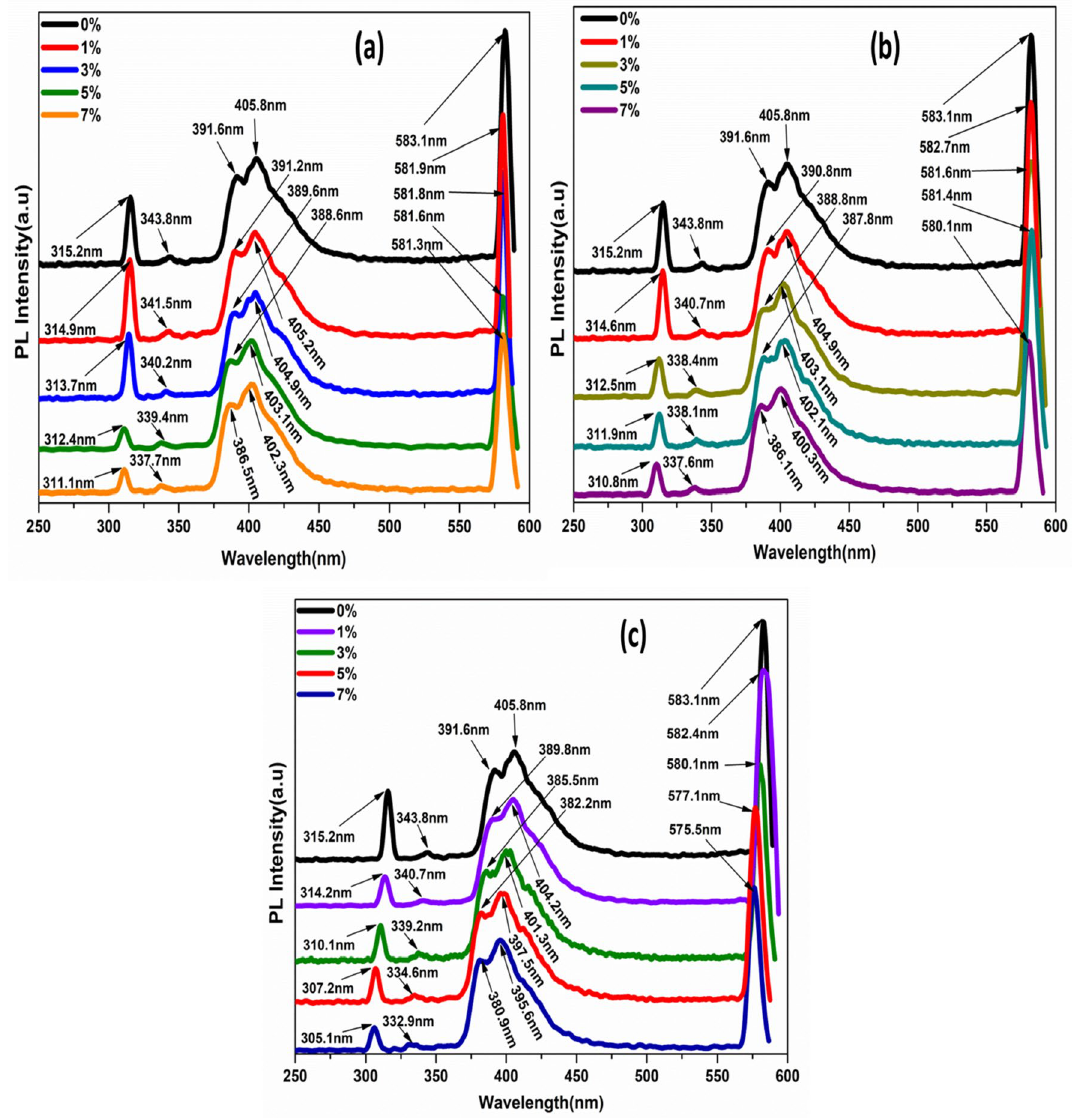
Figure 9. Photoluminescence spectra of Pure MgO metal oxide and transition metal MgO nanoparticles doped with: ( a ) Ni, ( b ) Co and ( c ) Fe with the different The PL spectra of transition metal 1% Ni-doped MgO nanoparticles have five peaks originating around 314.9, 341.5, 391.2, 405.2, and 581.9 nm. The first and second peak corresponds with the ultraviolet region. The other three peaks correlate to violet, violet, and yellow in the visible region, respectively. The intensity of emission peaks varies as the concentration of Ni in the MgO nanoparticles varies, as shown in Fig. 9a. Furthermore, the peak was shifted toward a lower wavelength with increasing Ni ion concentrations. Figure 9b presented photoluminescence (PL) spectra at room temperature of transition metal Co-doped MgO nanoparticles at different concentrations. Five peaks were observed in the photoluminescence spectra. In the transition metal, 1% Co-doped MgO nanoparticles the near band edge (NBE) emission observed at 314.6 and 340.7 nm (ultraviolet emission). Two peaks appeared at about 390.8 and 404.9 nm, corresponding to a violet emission band. Finally, the yellow emission band was observed at 582.7 nm in the visible region. Figure 9c depicted photoluminescence (PL) spectra of transition metal Fe-doped MgO nanoparticles with different doping concentrations. Five peaks were exhibited for all the different concentrations of the transition metal Fe-doped MgO nanoparticles. For example, on the spectra of transition metal 1% Fe-doped MgO nano- particles, there are two peaks centered at around 314.2 and 340.7 nm in the ultraviolet (UV) region attributed to the near band edge (NBE) emission. Violet emission peaks were centered at 389.8 and 404.2 nm, and yellow emission peaks appeared at 582. 4 nm. The peak intensities varied with the increasing ion doping concentrations for all prepared samples, as observed in Fig. 9c. The peak, wavelength, and energy band gap values of pure and different transition metal oxide concentrations-doped MgO nanoparticles are tabulated in Table 2.